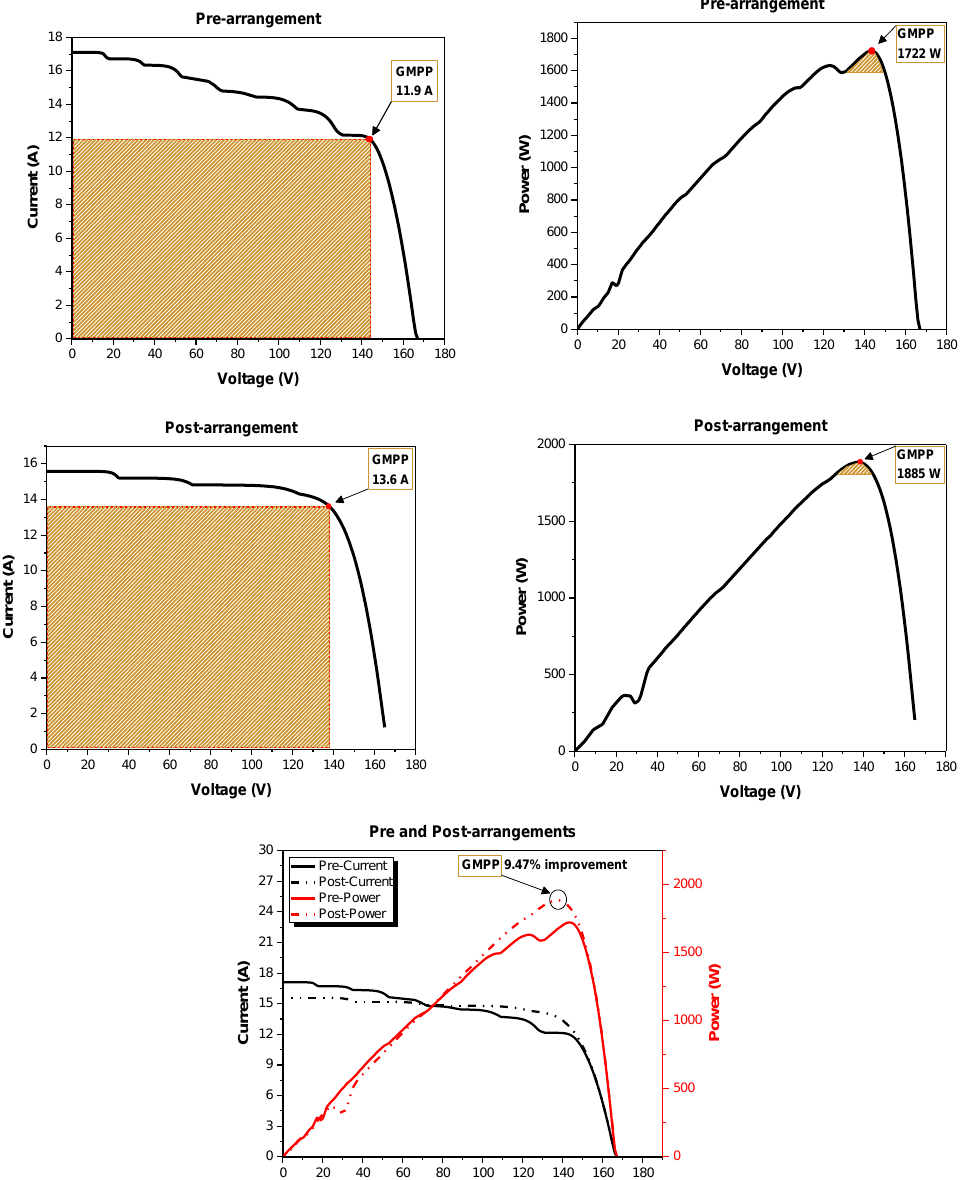
Figure 12. The output of the Array (pre-post rearrangements) for case 2.